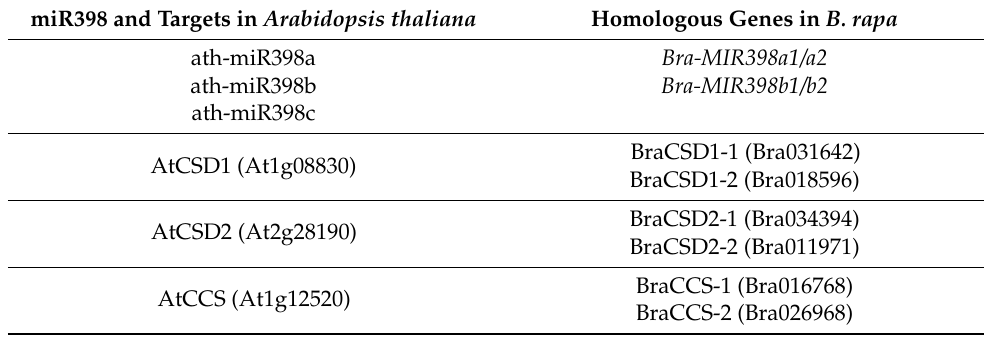
Table 1. miR398 and its target genes in B. rapa